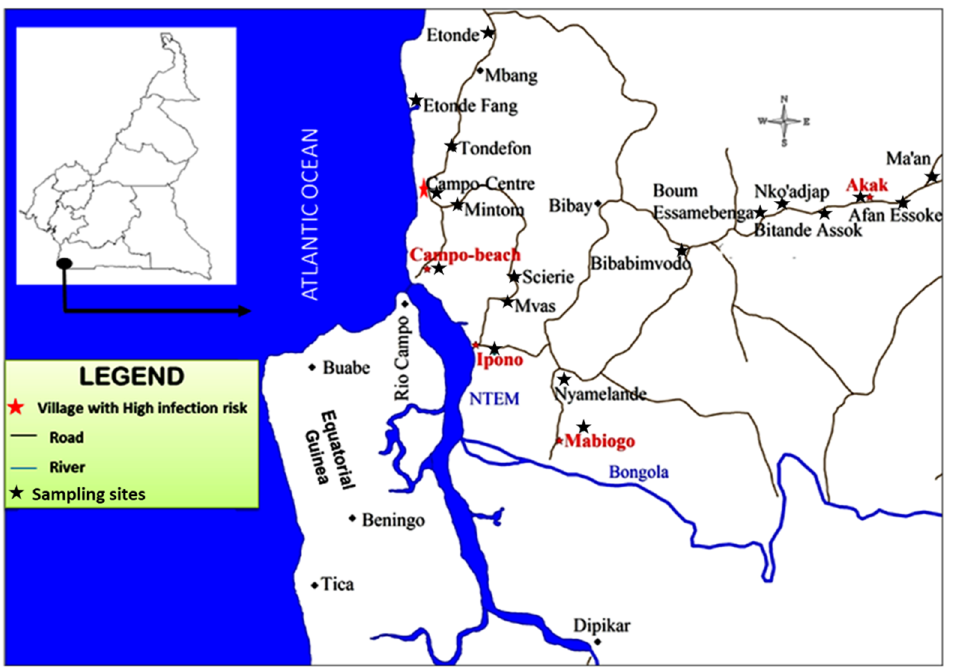
Figure 1. Map of Campo HAT focus (extracted and modified from the National Institute of Cartography Yaoundé Cameroon, 1976 topographic map).